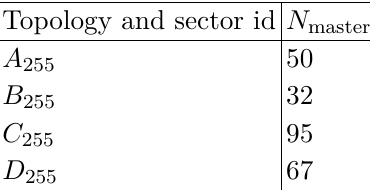
Table 2 . The number of master integrals for a given top sector, if we treat each top sector